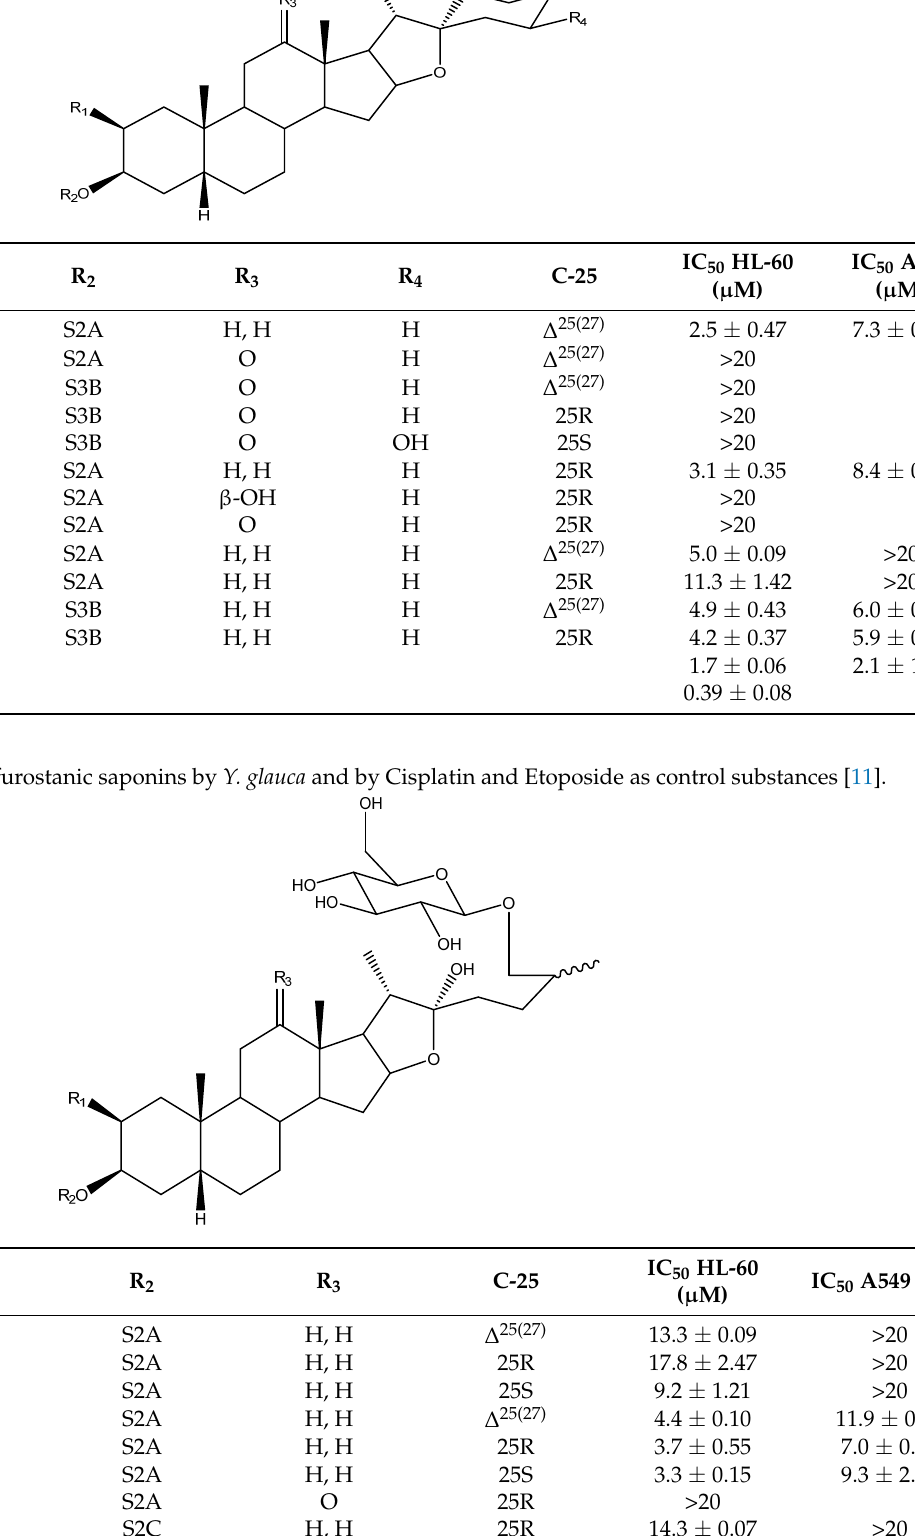
Table 2. Bioactivity of spirostanic saponins by Y. glauca and by cisplatin and etoposide as control substances [11].